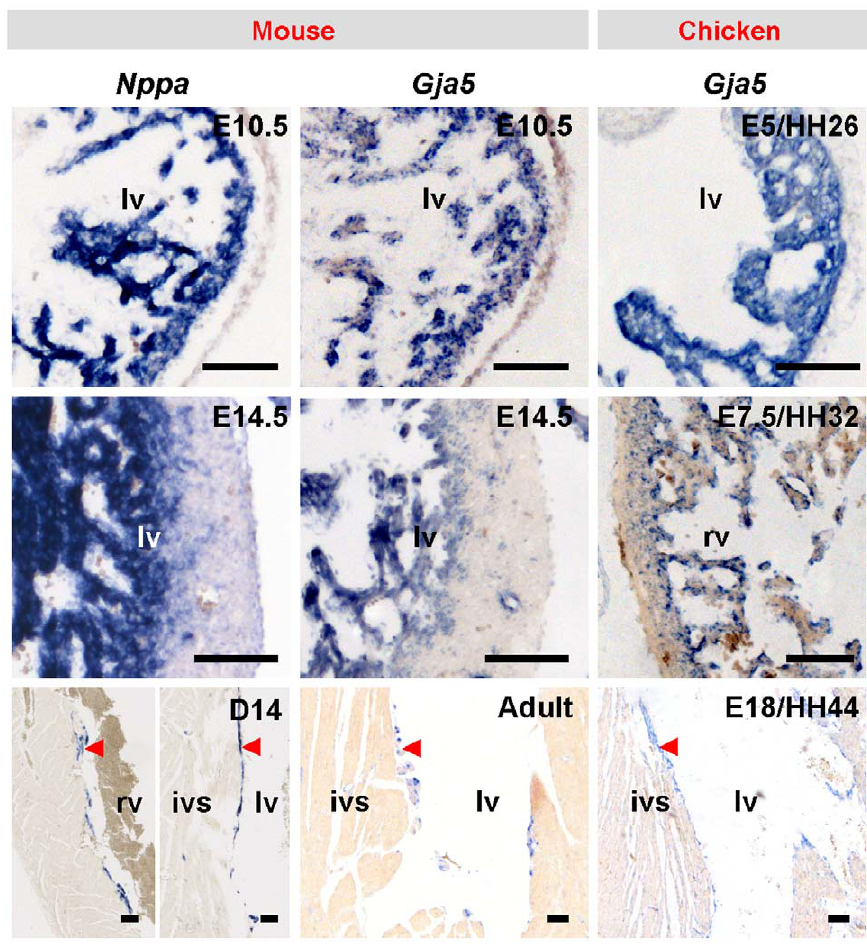
Figure 8. Development of compact walls. The development of the compact walls ( Nppa and Gja5 negative) of mammals and birds leaves the trabeculated myocardium ( Nppa and Gja5 positive) as a thin inner lining of the ventricular lumina in the fully formed hearts. Nppa is not expressed birds[36]. Scalebars, 100 m m. ivs, interventricular septum; lv, left ventricle. basal region (Fig. S5). The activation maps and expression data indicate that the trabeculated ventricular wall of the ectothermic vertebrates function essentially as an isotropic conduction network.